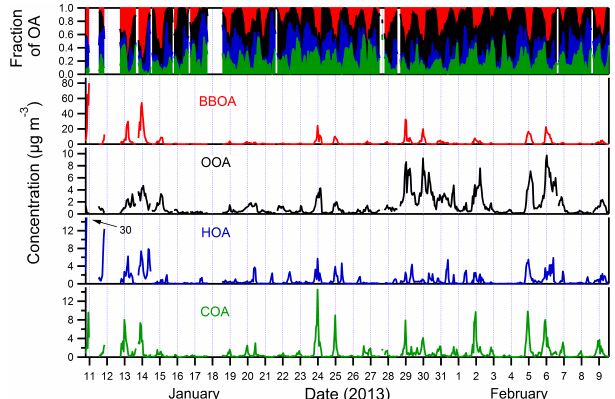
Figure 7. The hourly fractional contribution to OA and time series of the PMF factors during the Athens campaign. During the first day, HOA reached levels up to 30µgm − 3